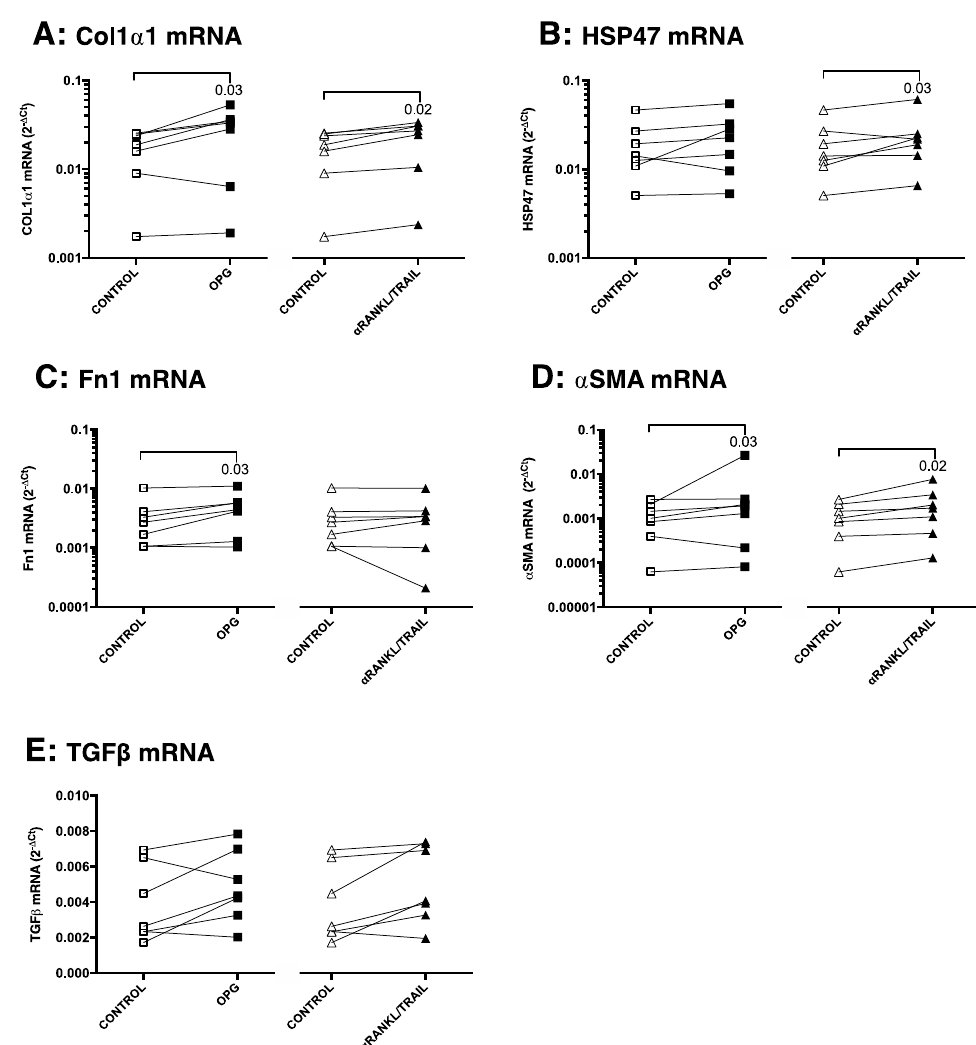
Figure 7. Treatment with neutralizing antibodies against RANKL and TRAIL resembles the effects of OPG. Groups were compared using a Friedman test with a Dunn’s correction for multiple testing, and p < 0.05 was considered significant.